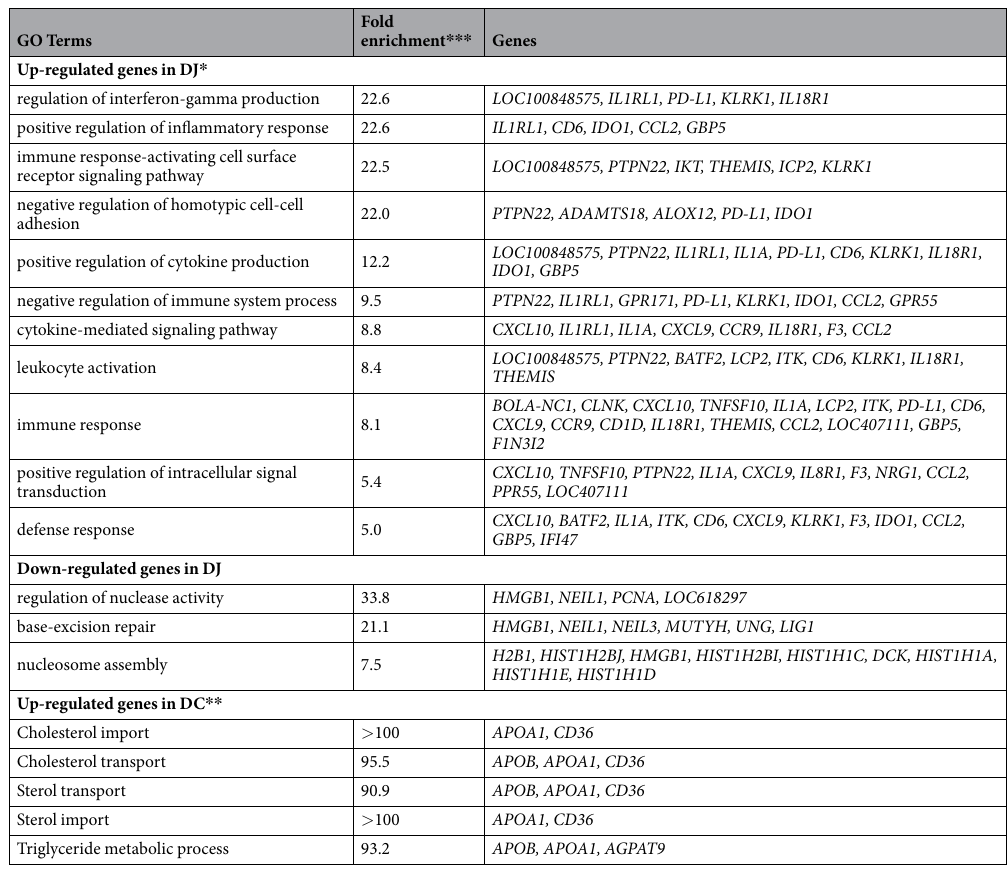
Table 1. Gene ontology (GO) term enrichment (biological process, p-value < 0.05) for DE genes between non-shedders and super-shedders in distal jejunum and descending colon, no functional terms were enriched for other tissues (p-value ≥ 0.05). * Distal jejunum. ** Descending colon. *** Number of genes observed in the uploaded list over the expected number genes involved in that term for Bos taurus (which is determined by the Gene Ontology